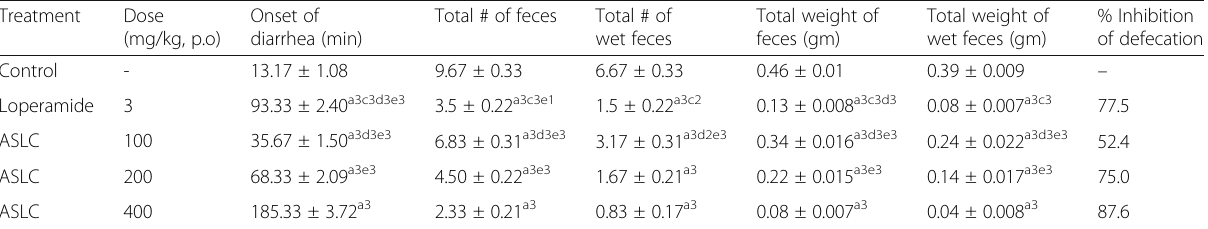
Table 1 Effect of the aqueous stem extract of L. camara on castor oil induced diarrhea in mice Treatment